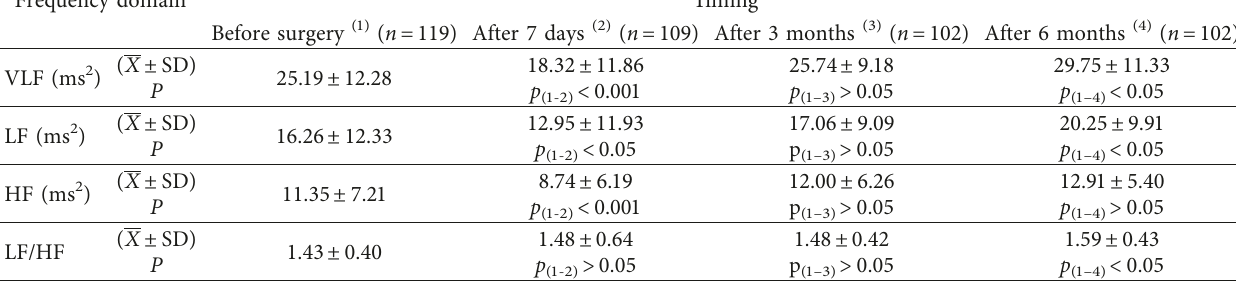
Table 2: Heart rate variability by frequency domain before and after surgery.